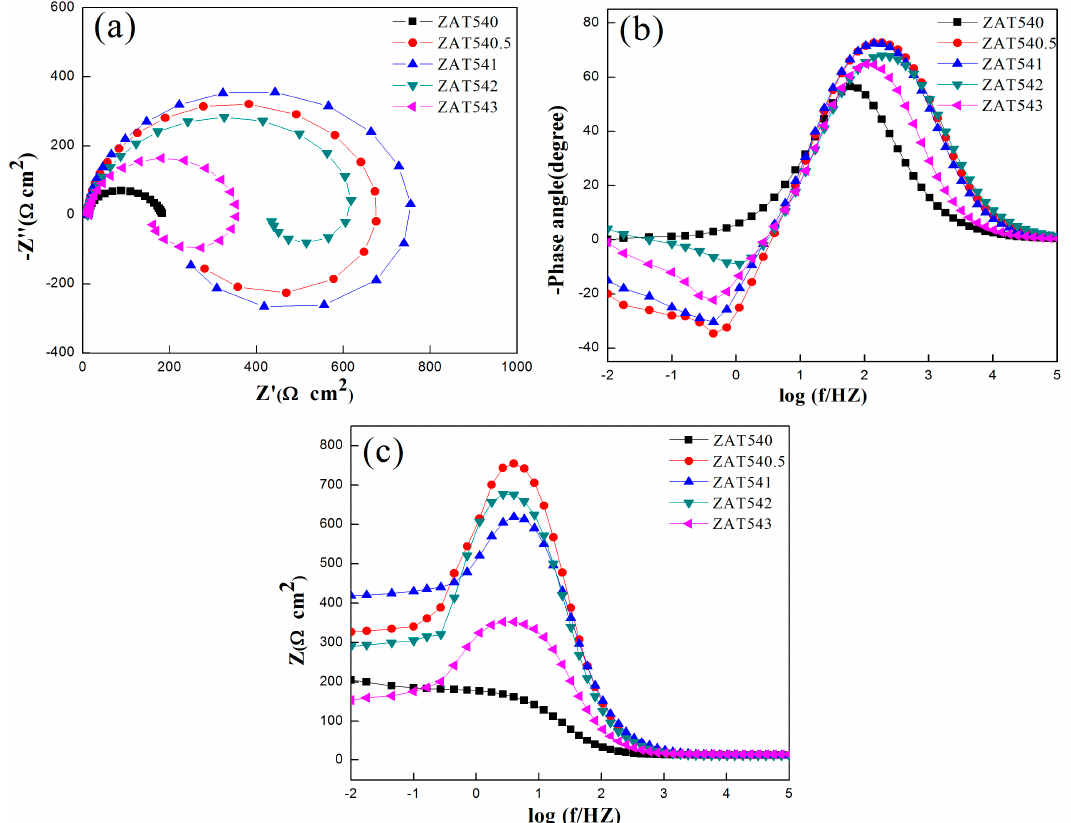
Figure 6. ( a ) Nyquist plots of ZAT54x alloys. ( b ) Bode plots of phase angle vs frequency for ZAT54x alloys. ( c ) Bode plots of impedance vs frequency for ZAT54x alloys.